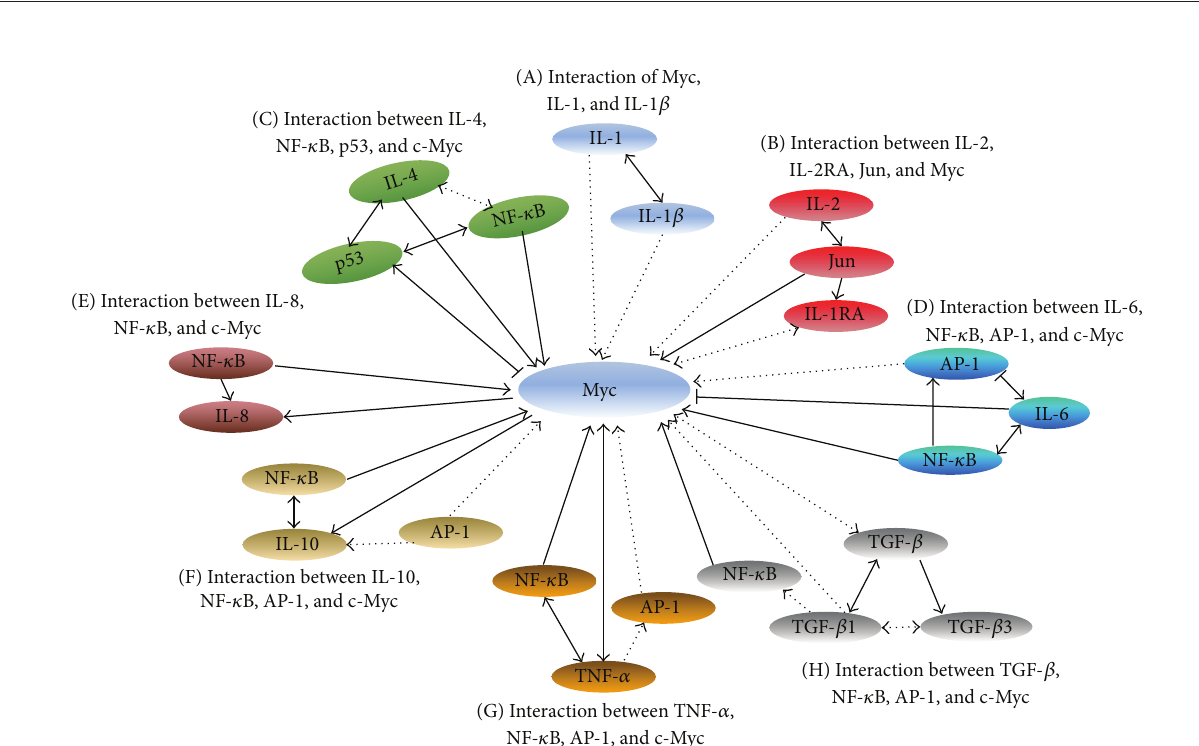
Figure 1: The interaction between Myc and mediators of inflammation. Arrow = positive regulation, Dot arrow = positive regulation with unclear mechanisms. Arrows in beginning and end = regulation of each other positively. Bar = negative regulation. IL-2RA: interleukin 2 (IL-2) receptor alpha. (A) Interaction of Myc, IL-1, and IL-1 𝛽 . (B) Interaction between IL-2, IL-2RA, Jun, and Myc. (C) Interaction between IL-4, NF- 𝜅 B, p53, and c-Myc. (D) Interaction between IL-6, NF- 𝜅 B, AP-1, and c-Myc. (E) Interaction between IL-8, NF- 𝜅 B, and c-Myc. (F) Interaction between IL-10, NF- 𝜅 B, AP-1, and c-Myc. (G) Interaction between TNF- 𝛼 , NF- 𝜅 B, AP-1 and c-Myc. (H) Interaction between TGF- 𝛽 , NF- 𝜅 B, and